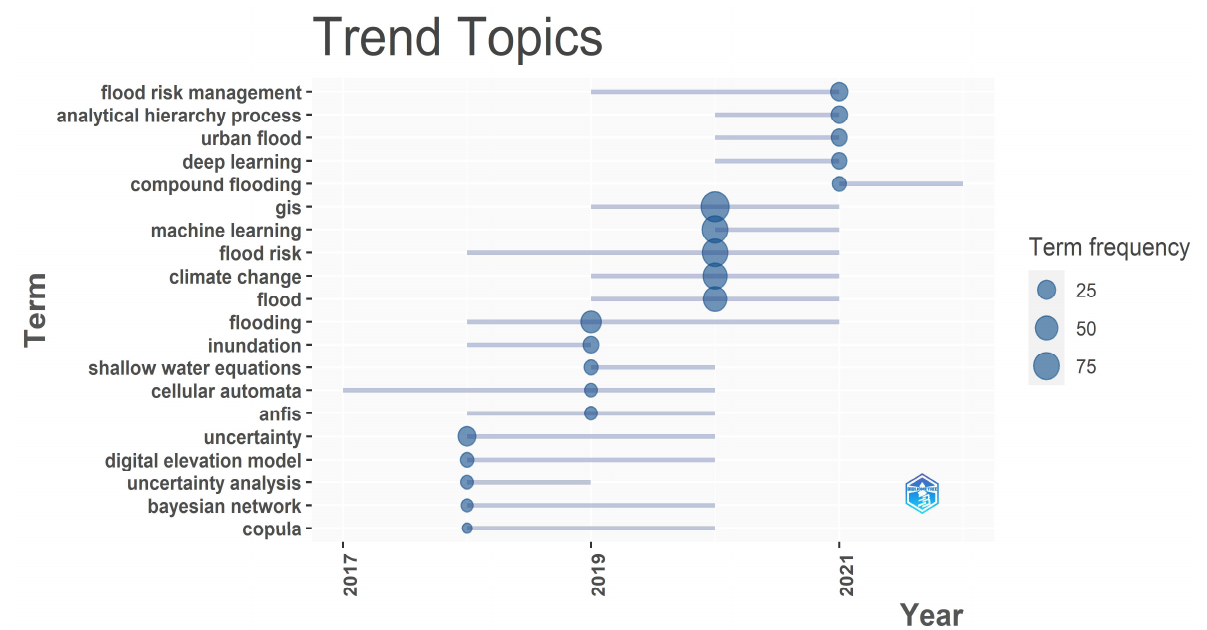
Figure 5. The trending topics plot in the Flood prediction 2017–2022.